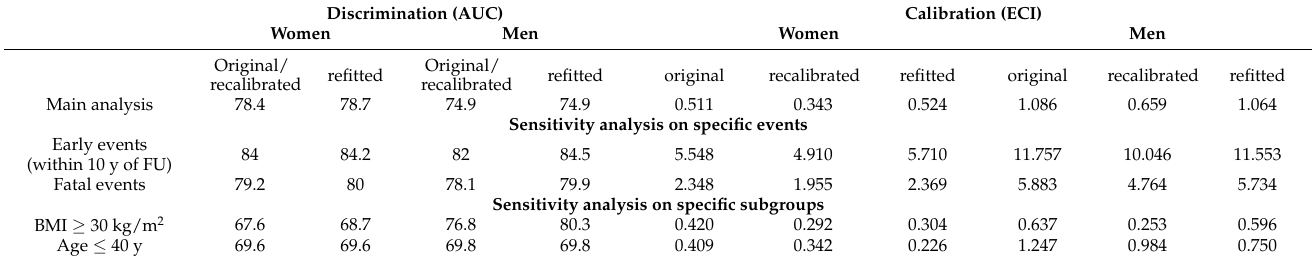
Table 2. Discrimination (values as AUC) and calibration performance (values as ECI) of dif- ferent FRS30y versions for main and sensitivity analyses. As recalibration does not affect dis- crimination performance, the original and recalibrated versions are subsumed presentation of discrimination